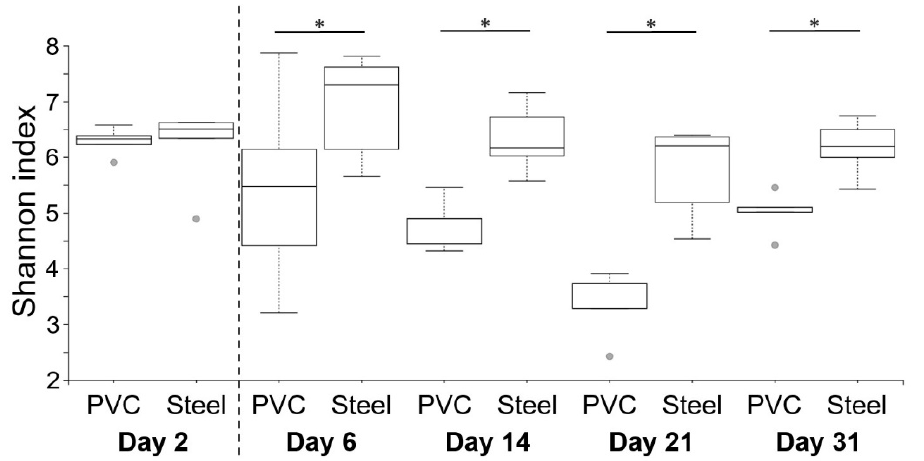
Figure 6. Comparison of α -diversity on PVC and steel coupons during the experiment. α -diversity was determined using the Shannon index value. The dotted line indicates the animal’s entry into the building. Pairwise comparisons between materials per day are shown with an asterisk (* p < 0.05).